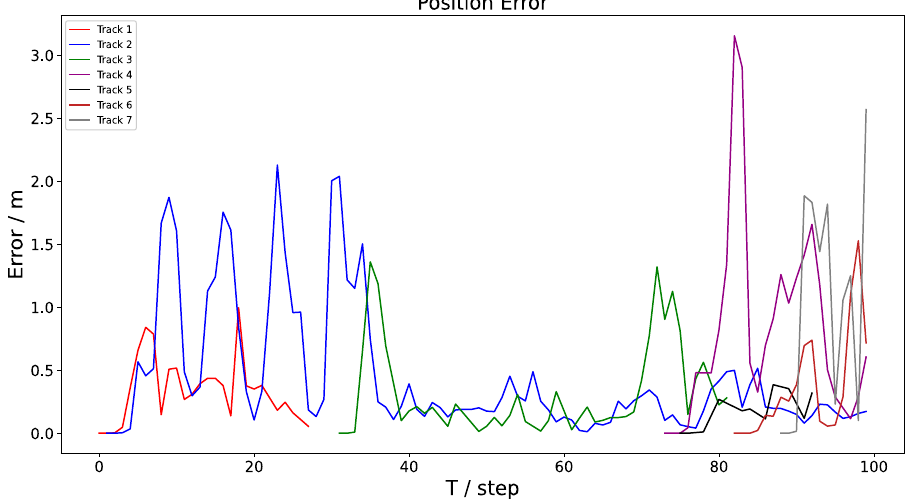
Figure 28. Tracking error between the prediction and actual track (CMKF-REMTT).